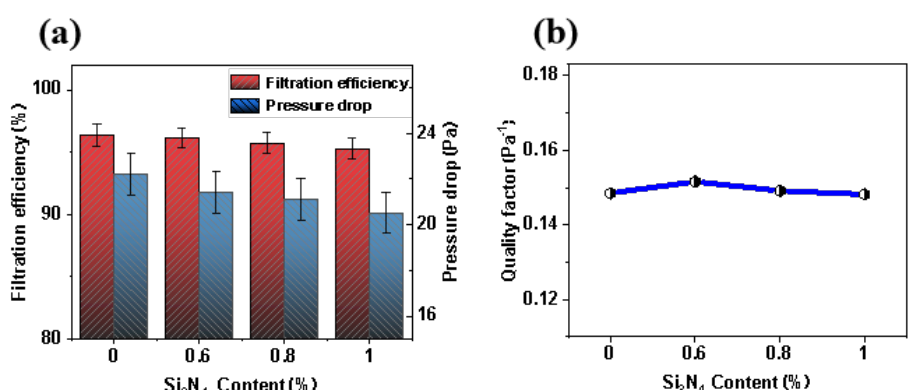
Figure 8. Filtration performance diagram of nonwoven materials with different Si 3 N 4 content: ( a ) filtration efficiency and pressure drop; ( b ) quality factor.